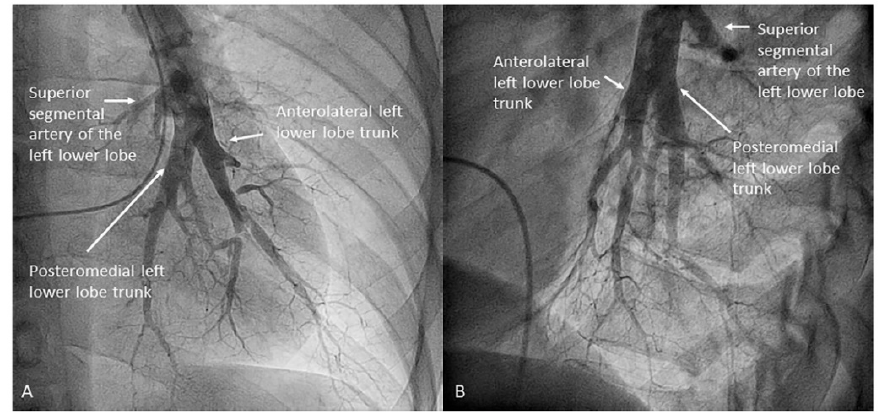
Figure 15. Branches for the left lower lobe: ( A ) anteroposterior view and ( B ) lateral view.